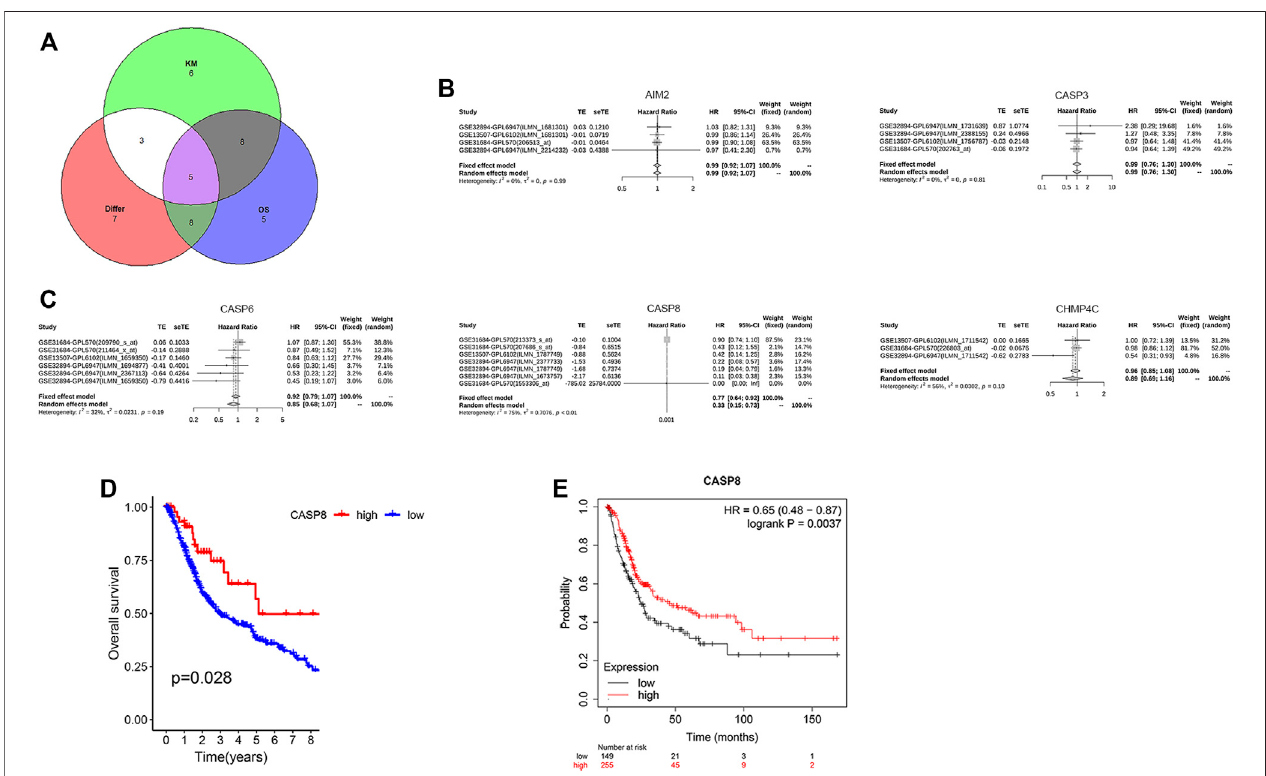
FIGURE5| CASP8wasidenti fi edasanovelprognosticbiomarker. (A) Theintersectiongenesofthedifferentiallyexpressedgenes(DEGs)andoverallsurvival(OS) shown by Venn diagrams. (B,C) Meta-survival analysis of AIM2, CASP3, CASP6, CASP8, and CHMP4C using the GENT2 database. Overall survival of CASP8 in patients with bladder cancer from (D) the TCGA database and GSE19423, and (E) the Kaplan – Meier